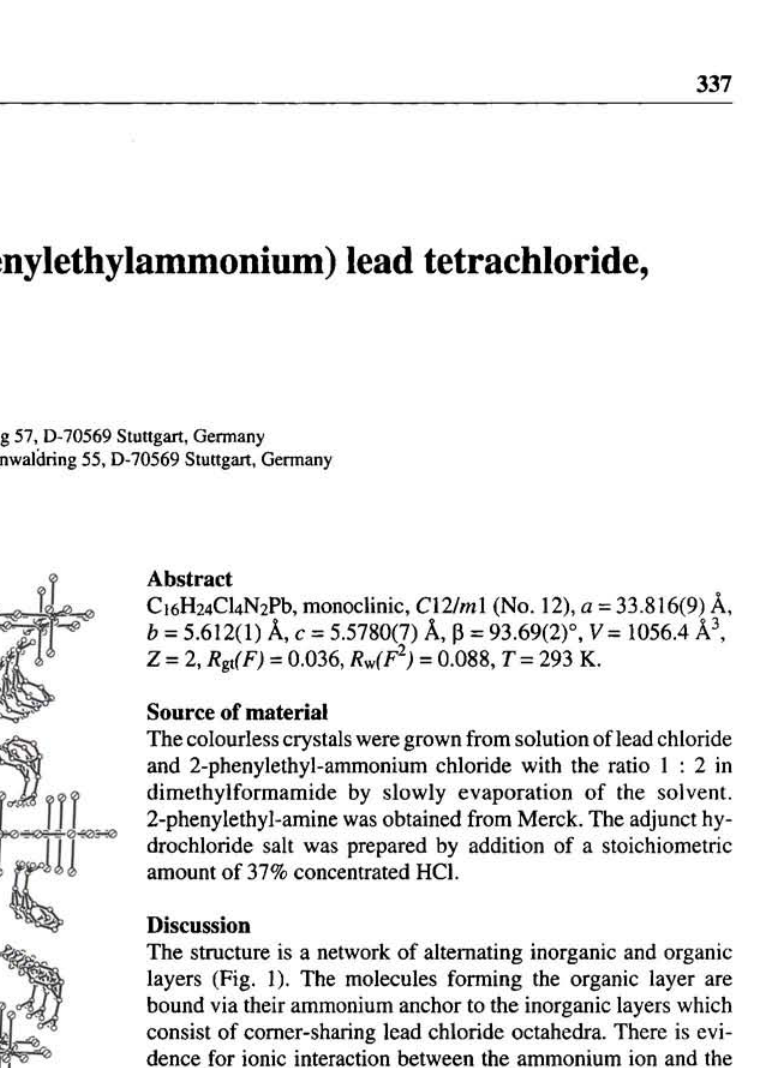
Fig. 1. Organic and inorganic layers in the (CgH9NH3)2PbCl4 structure.